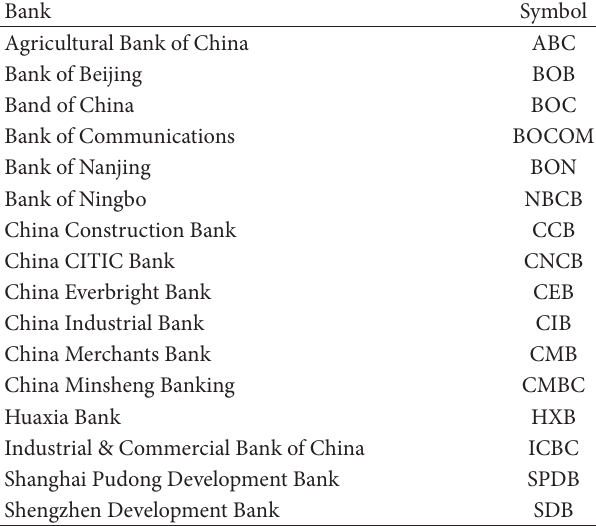
Table 1: 16 banks and respective symbols.